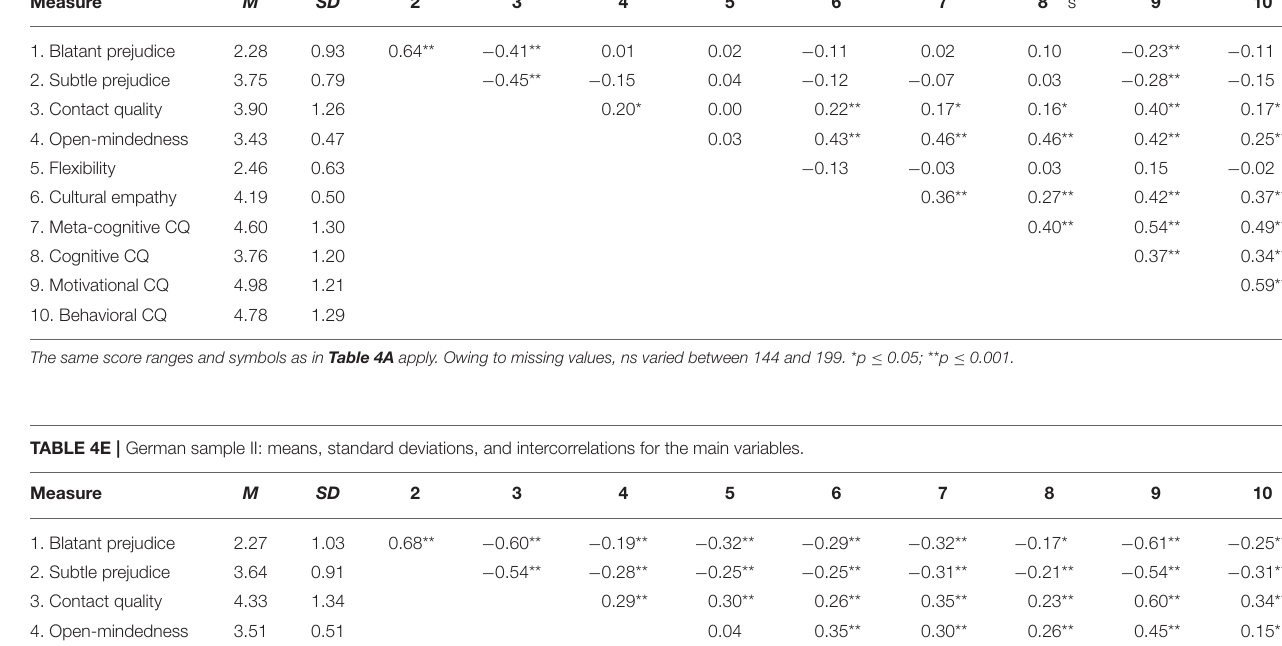
TABLE 4D | German sample I: means, standard deviations, and intercorrelations for the main variables. Measure M